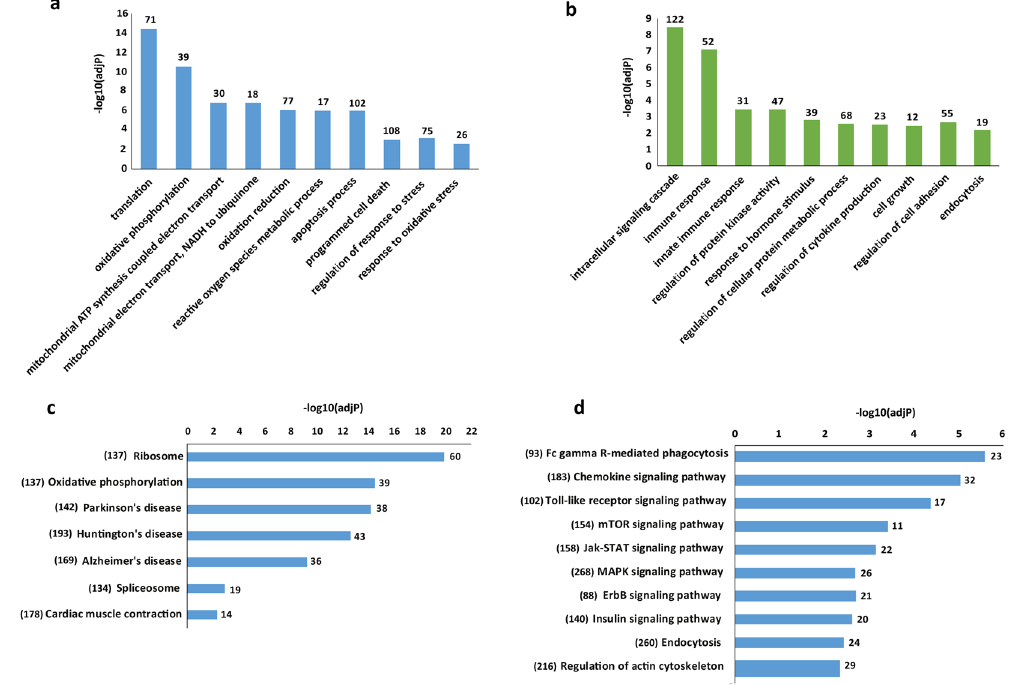
Figure 2. The GO and KEGG pathway analysis of DE protein-coding genes in primary monocytes of XLA patients compared to healthy subjects. The significant GO biological process terms (adj.P-value < 0.01) enriched for ( a ) upregulated genes, and ( b ) downregulated genes. The number of identified DE protein-coding genes enriched in each GO terms is depicted above bars of x-axis in the figure. The significant KEGG pathway terms enriched for ( c ) upregulated genes and ( d ) downregulated genes. Each statistical significance value (adj.p-value) was negative log-10 base transformed.The numbers in the brackets indicated the total number of genes available in the KEGG database for each pathway terms. The number of identified DE protein-coding genes enriched in each KEGG pathways is depicted above bars of x-axis in the figure.